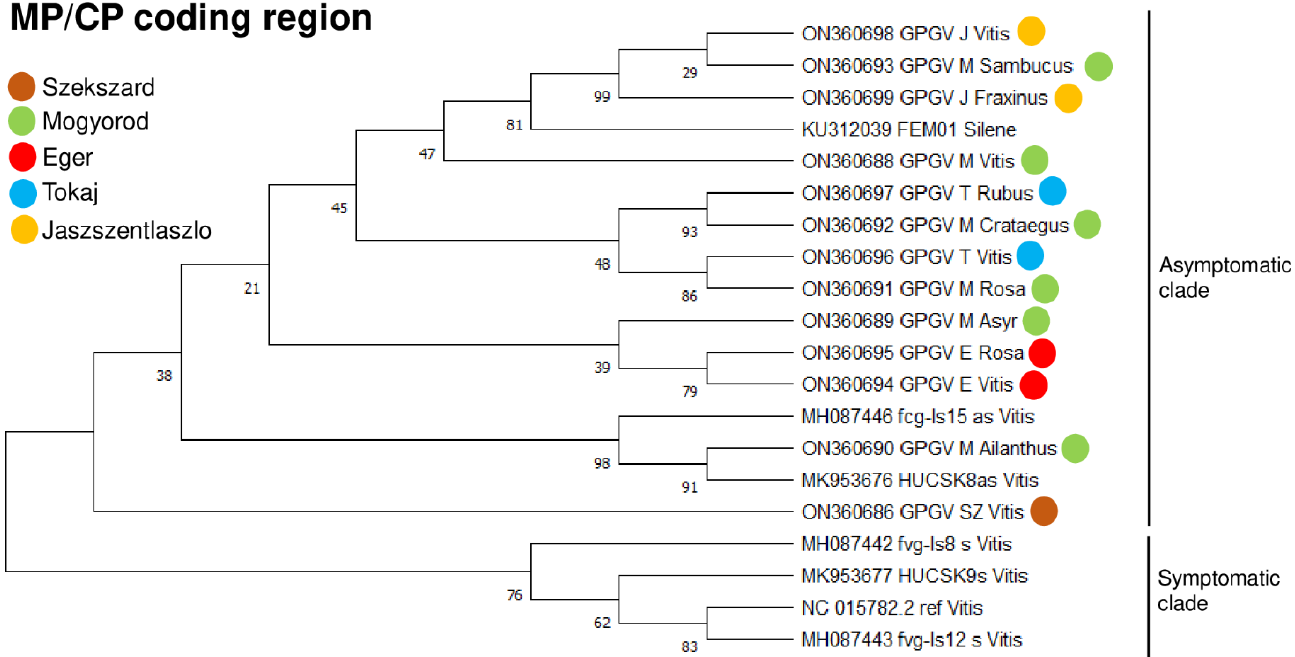
Figure 4 . Evolutionary analysis of MP/CP coding region using the maximum likelihood method. Evolutionary history was inferred using the maximum likelihood method and the Tamura–Nei model. Bootstrap consensus tree inferred from 1000 replicates is taken to represent evolutionary history of analyzed taxa. Branches corresponding to partitions reproduced in less than 50% bootstrap replicates are collapsed. Percentage of replicate trees in which associated taxa clustered together in bootstrap test (1000 replicates) is shown next to branches. Evolutionary analyses were conducted in MEGA11. Colored circles indicate geographical origins of strains. HUCSK8as and HUCSK9s are asymptomatic and symptomatic GPGV strains described in Hungary [5]. Ref is the GPGV reference genome from grapevine; FEM01 strain was described from Silene [11]. Symptomatic (s) and asymptomatic (as) GPGV isolates Fvg-is-8_s, 12_s, and 15_as were described by Tarquini et al. [12].